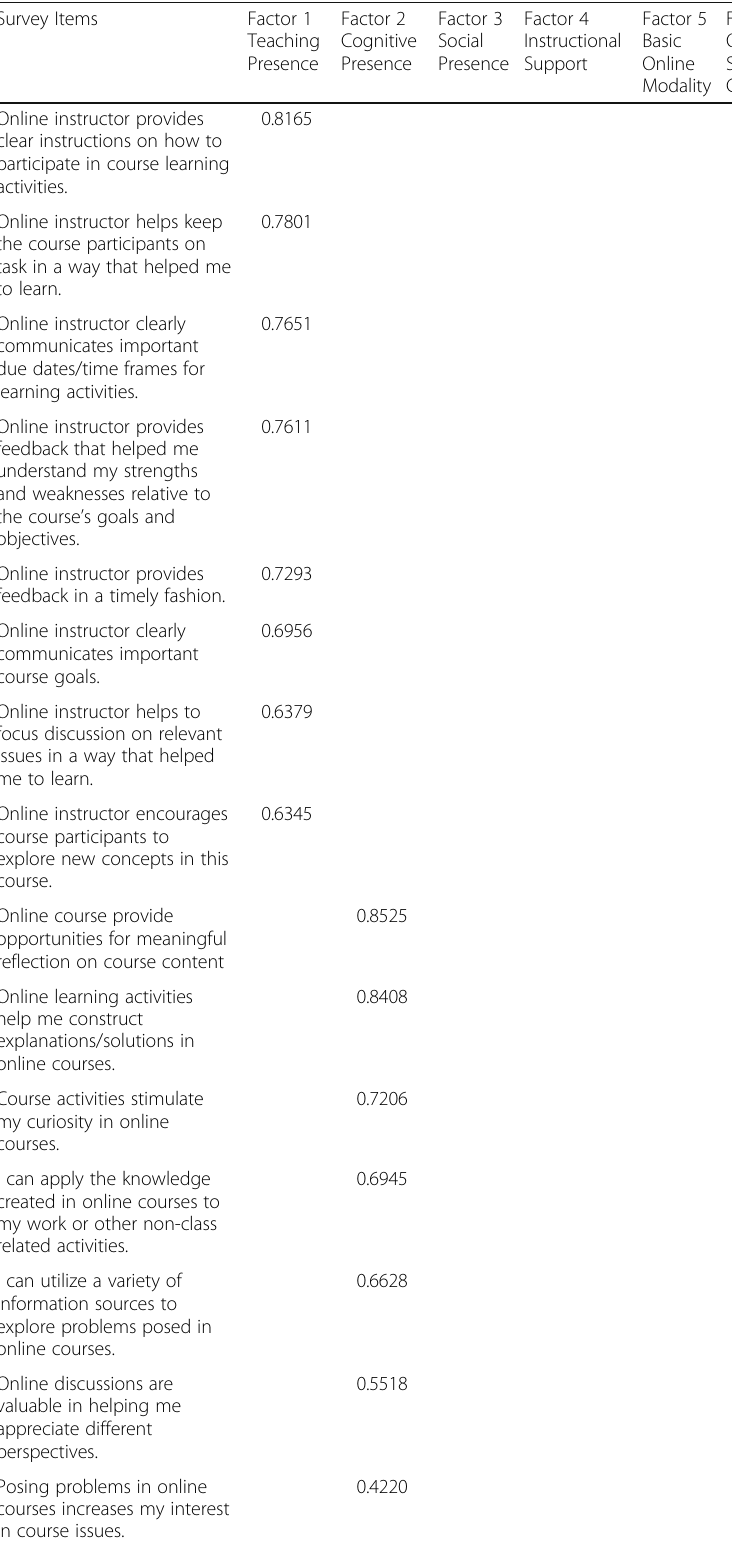
Table 2 Critical Success Factor Loading